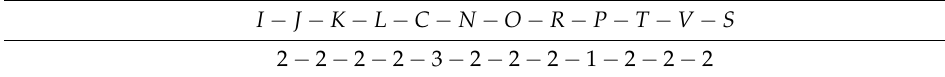
Table 3. Small sample problem